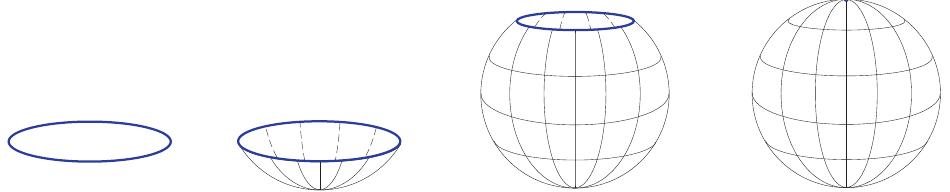
Figure 4. An example of creating a quotient space by gluing. Gluing the boundary of a circle onto a single point. The two-sphere S 2 is obtained by gluing the circle S 1 to a single